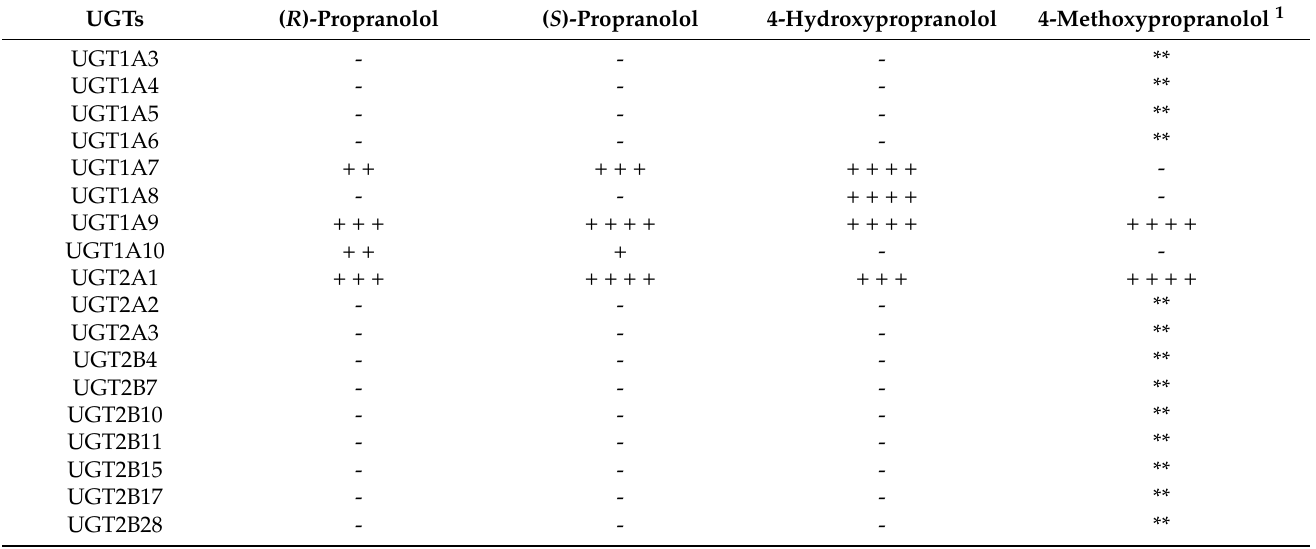
Table 1. The activity of 19 human UGTs on ( R )-propranolol, ( S )-propranolol, 4-hydroxypropranolol and 4-methoxypropranolol.